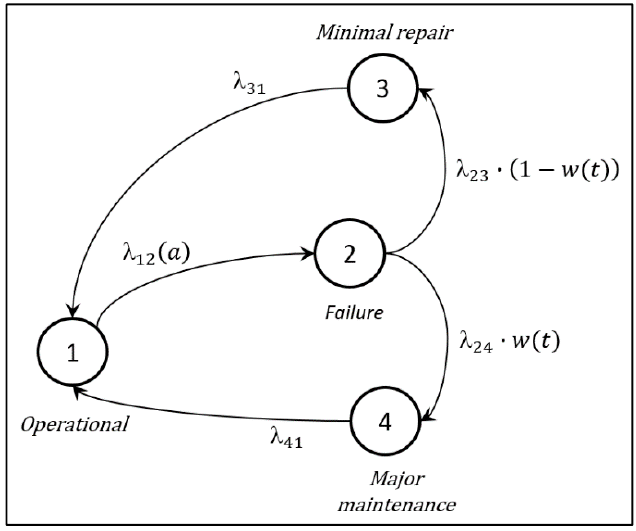
Figure 2. Transition diagram.